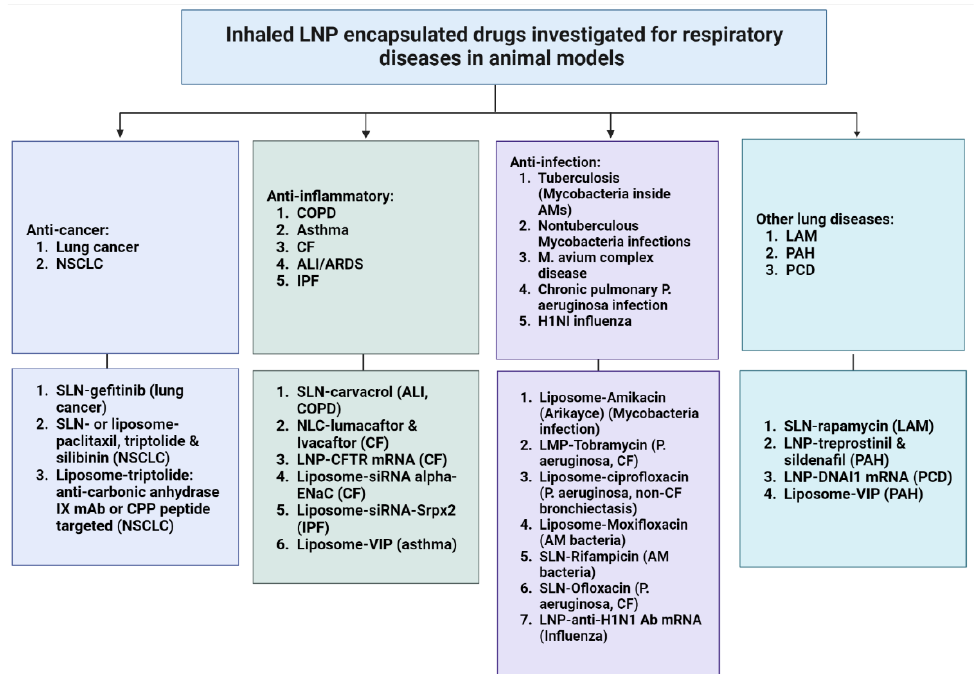
Figure 2. A summary of inhaled LNP-encapsulated drugs that have been investigated for respiratory diseases in animal models. Created with BioRender.com. ALI: Acute lung injury; ARDS: acute respiratory distress syndrome; COPD: chronic obstructive pulmonary disease; CF: Cystic fibrosis; IPF: idiopathic pulmonary fibrosis; LAM: lymphangioleiomyomatosis; LNP: lipid nanoparticle; NSCLC: non-small cell lung carcinoma; PAH: pulmonary arterial hypertension; PCD: primary ciliary dyskinesia; SLN: solid lipid nanoparticles; NLC: nanostructured lipid carriers; VIP: vasoactive intestinal peptide.